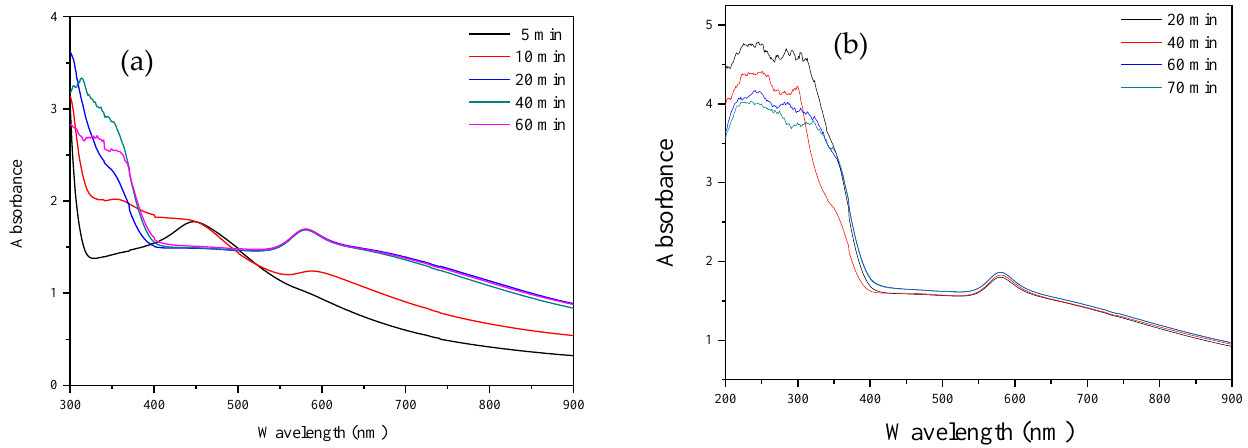
Figure 8. ( a ) UV – vis spectrogram of CuNPs synthesized under different reaction times. ( b ) UV – vis Figure 8. ( a ) UV–vis spectrogram of CuNPs synthesized under different reaction times. ( b ) UV–vis spectrogram of ascorbic acid when synthesizing CuNPs under different reaction times. spectrogram of ascorbic acid when synthesizing CuNPs under different reaction